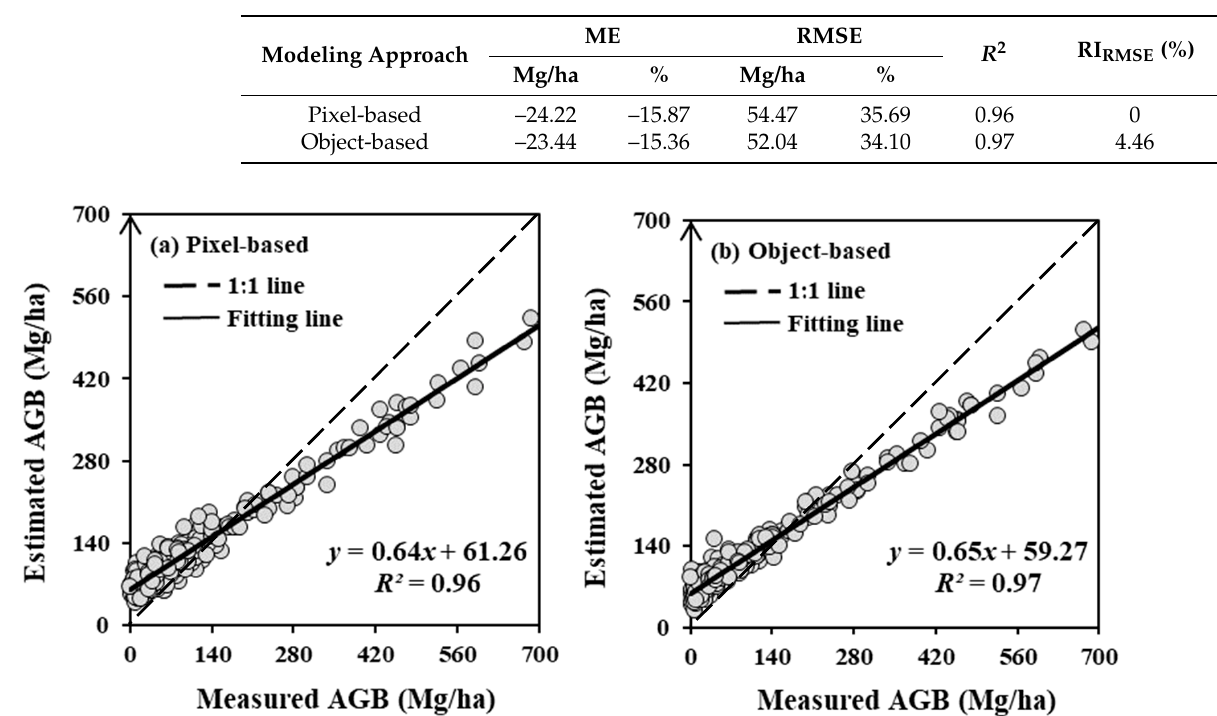
Figure 7. Scatter diagrams of estimated AGB versus measured values.